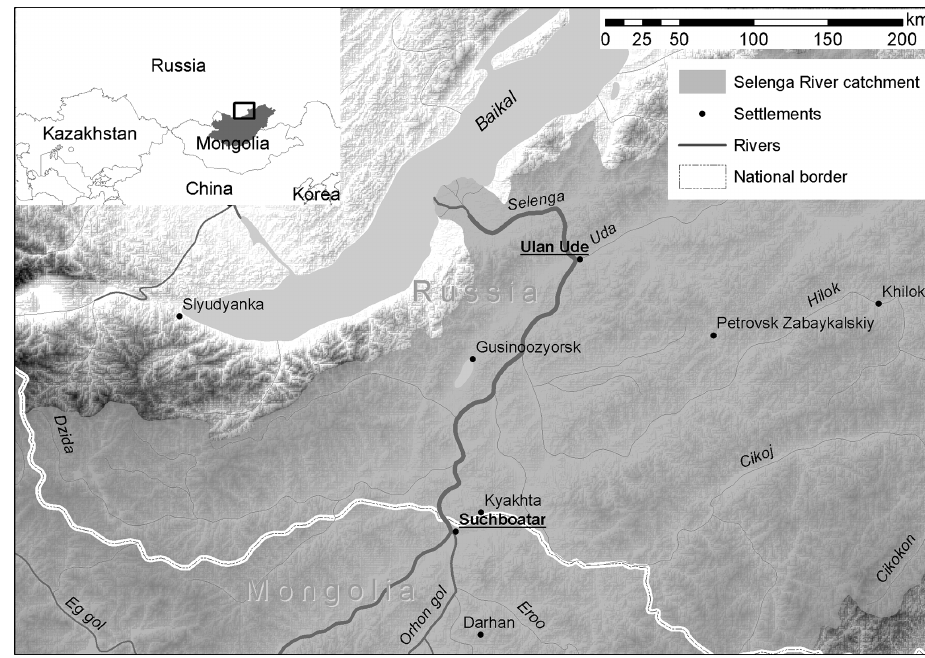
Figure 1. The location of the study